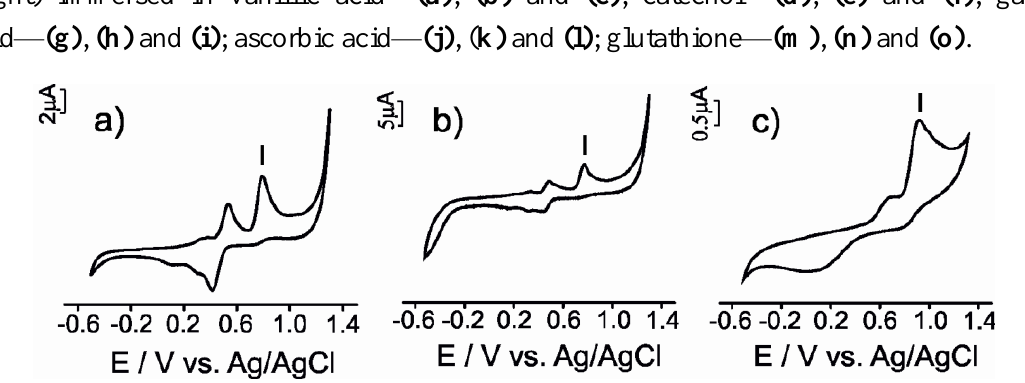
Figure 4. The voltammetric signals of G-CPE (left),  S-CPE (middle) and CNT-CPE (right) immersed in vanillic acid— (a) , (b) and (c) ; catechol —(d) , (e) and (f) ; gallic acid— (g) , (h) and (i) ; ascorbic acid— (j) , ( k) and (l) ; glutathione— (m) , (n) and (o)